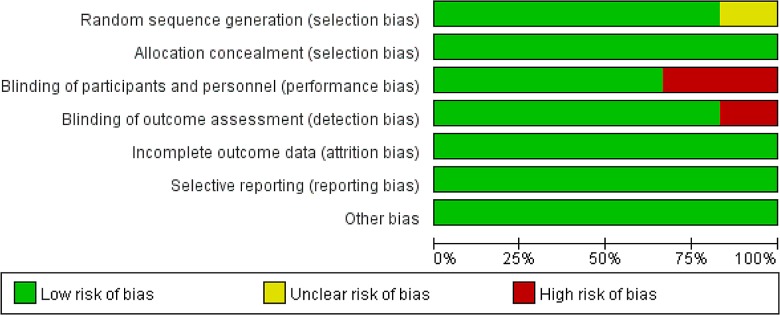
Risk of Bias Graph.